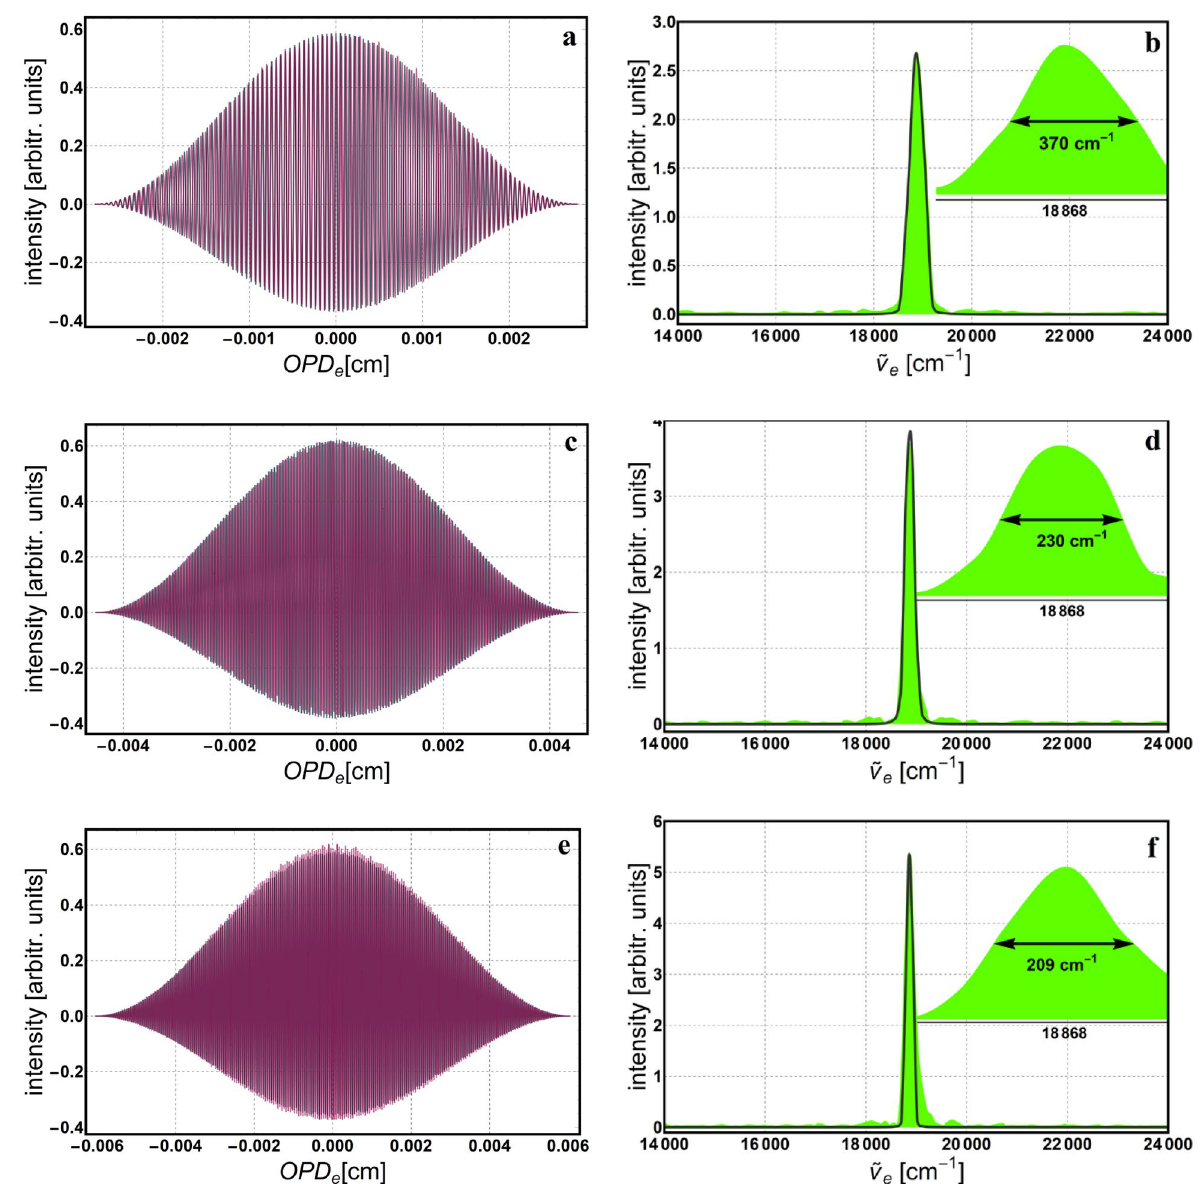
Figure 5. Simulation (gray) and experimental (color) reconstruction of both apodized interferogram and the corresponding monochromatic spectrum for the 530 nm source: ( a , b ) 512; ( c , d ) 1024 and ( e , f ) 2048 data points. Insets show the enlarged area around the peak, with the corresponding spectral width value computed as the